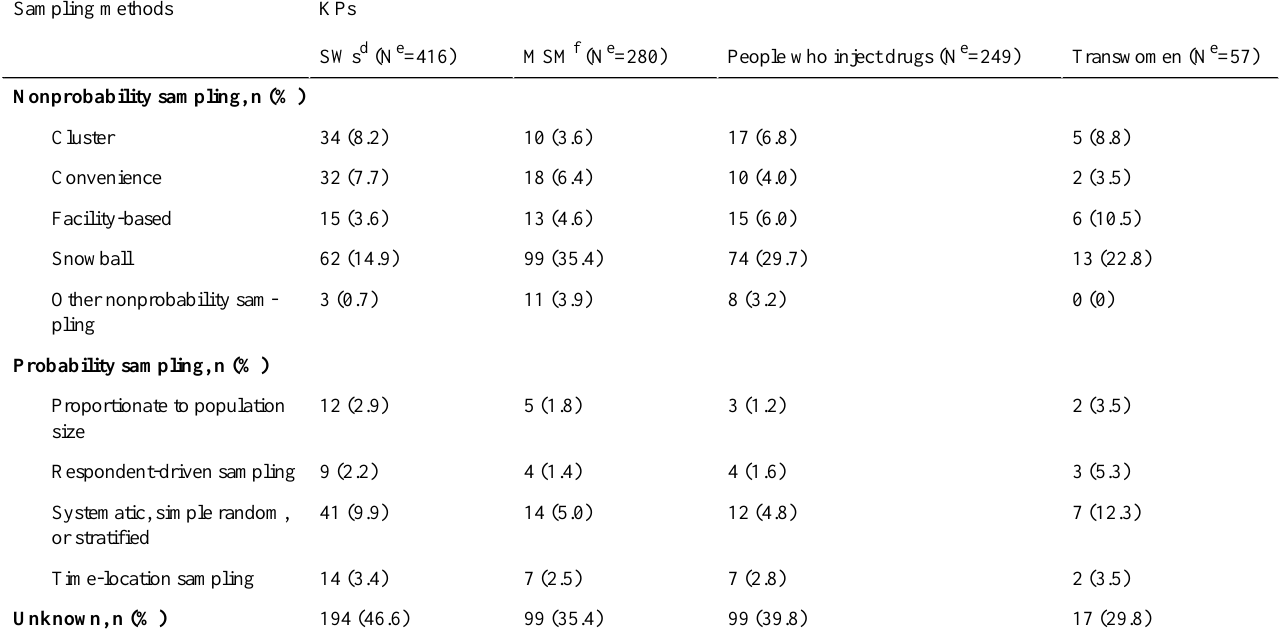
Table 3. Sampling methods used for surveys in SNUs a with at least 3 data points for any KP b (N c =68). KPsSampling